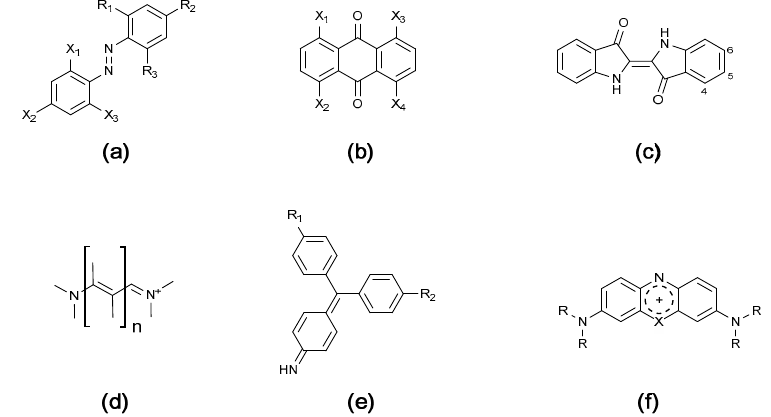
Figure 3. Core structure of some of the most used textile dyes. ( a ) azo; ( b ) anthraquinone; ( c ) indigo; ( d ) cationic; ( e ) triphenylmethane; ( f ) other cationic dyes with condensed tricyclic systems derived from acridine/phenazine/phenoxazine or similar structures, where one heteroatom bears a net positive charge.